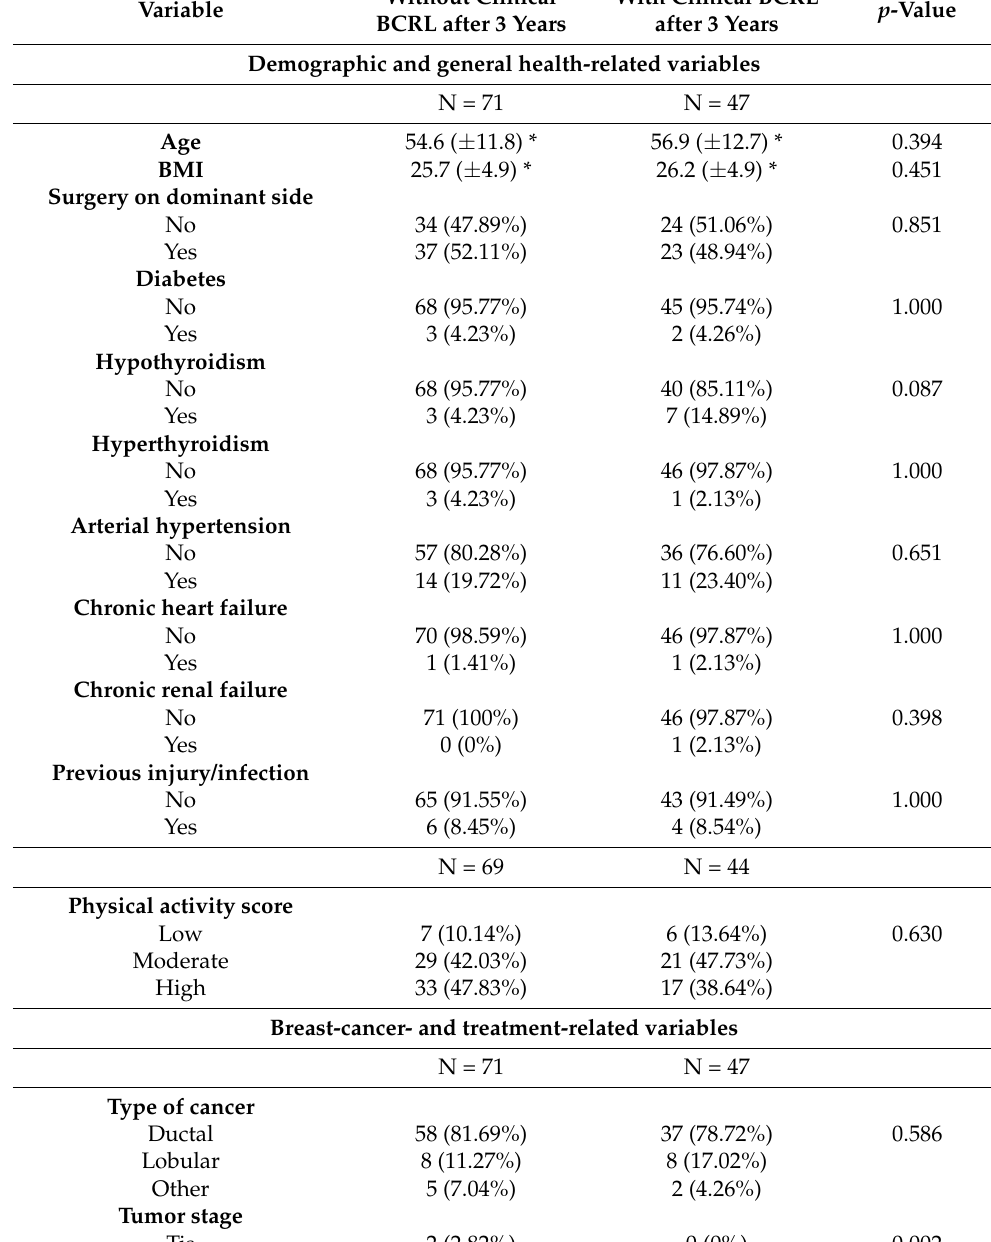
Table 1. Variables of the study participants.